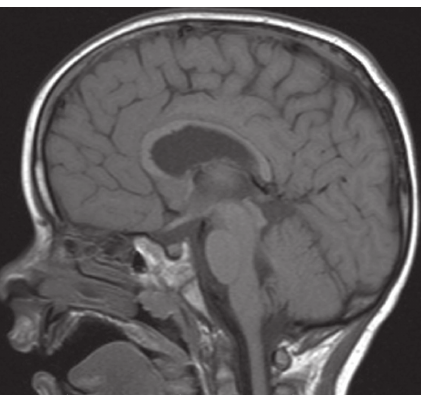
Figure 1: Preoperative MRI with apparent aqueductal obliteration. peritoneal drainage catheter. In 1 patient, ETV was performed as a planned surgery in full V-P drainage functionality.